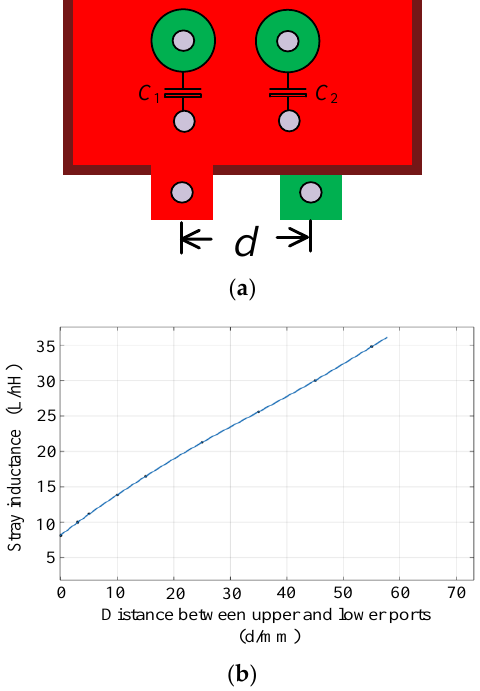
Figure 11. Relationship between stray inductance and connection point distance of laminated busbar. ( a ) The distance between the two connection points. ( b ) Stray inductance curve with distance d .